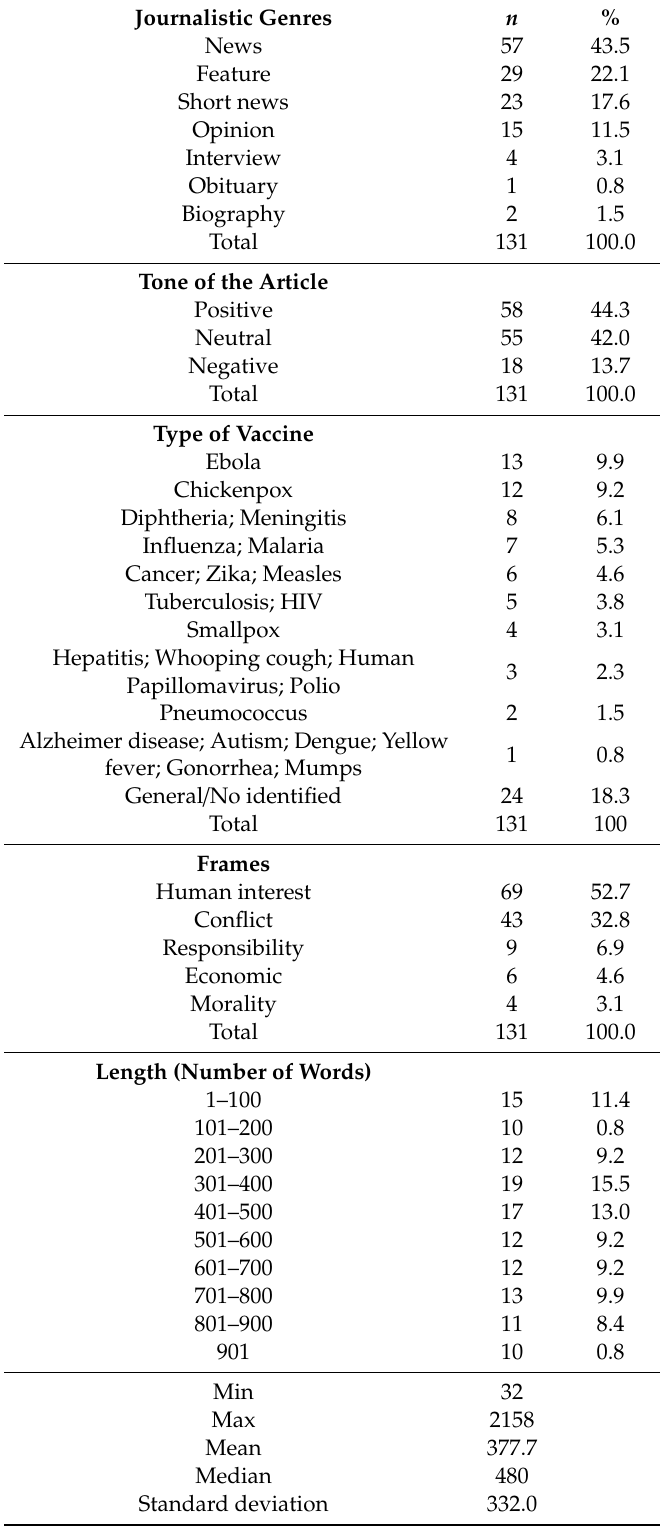
Table 1. Main features of the